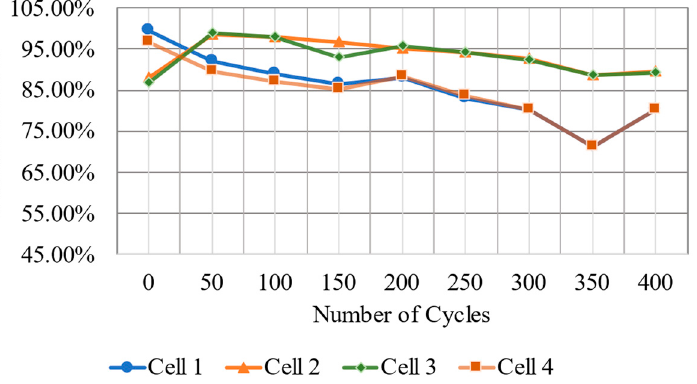
Figure 12. Contribution of R SEI to R ct + R SEI for the four cells as a function of the number of cycles. Using this method provides the possibility of reliable approximation of SoH without extrapolation to end-of-life, providing an accurate measurement.